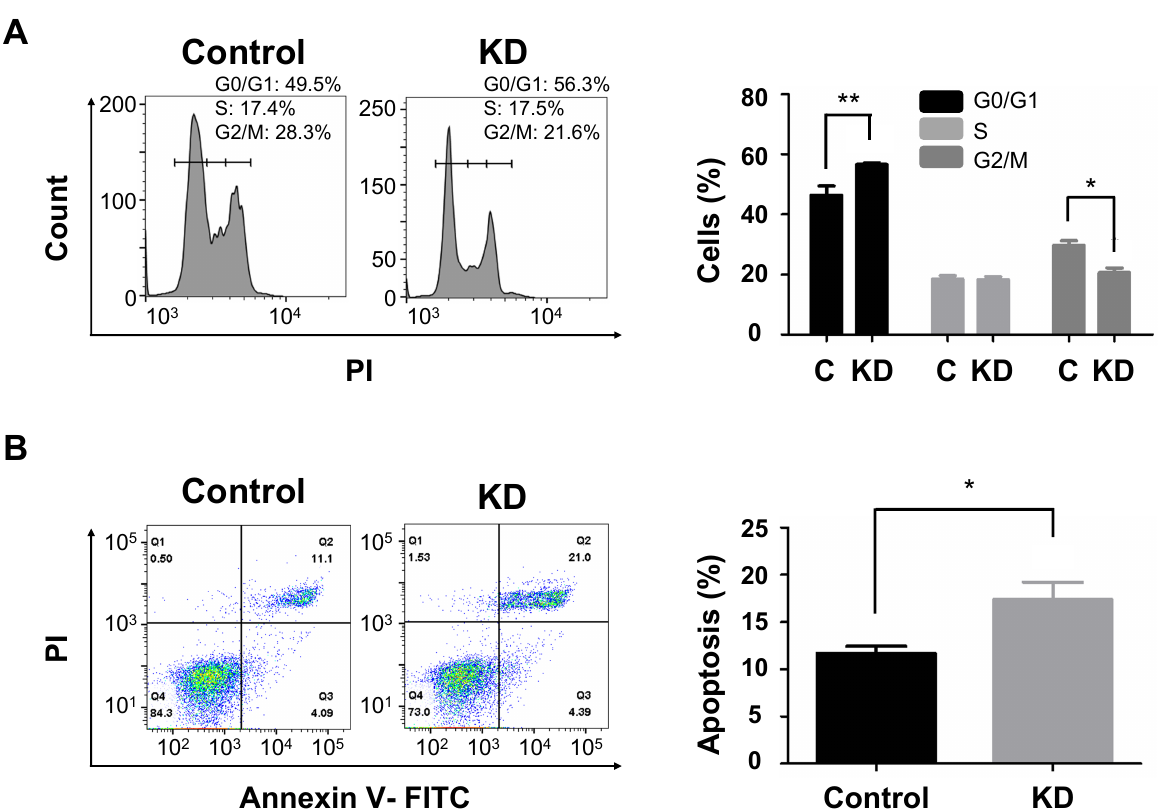
Figure 3. Downregulation of PLEKHA8P1 promotes cell cycle arrest and apoptosis of HCC cells. ( A ) Analysis of cell cycle phase distribution through flow cytometry, with concurrent representation in histogram form. ( B ) Apoptotic cells were determined by flow cytometry and representative image of flow cytometry dot-plot is presented. All data were acquired from three independent experiments and p -values were determined by two-tailed unpaired t-test analysis. * p < 0.05; ** p < 0.01; C,